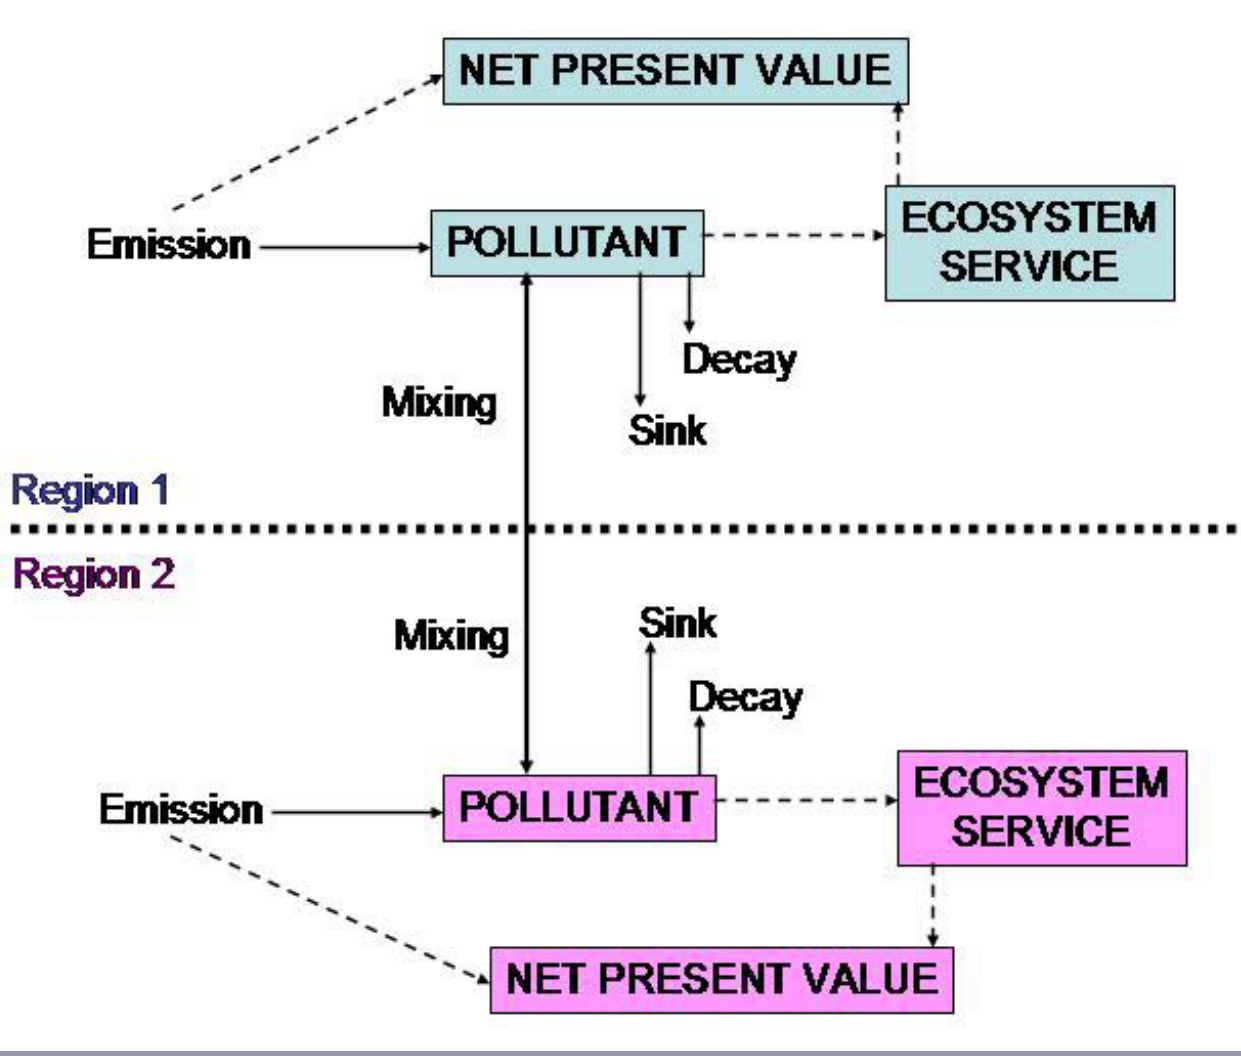
Fig. 1 . Box-arrow diagram of the model showing flows of the pollutant and economic effects in the two